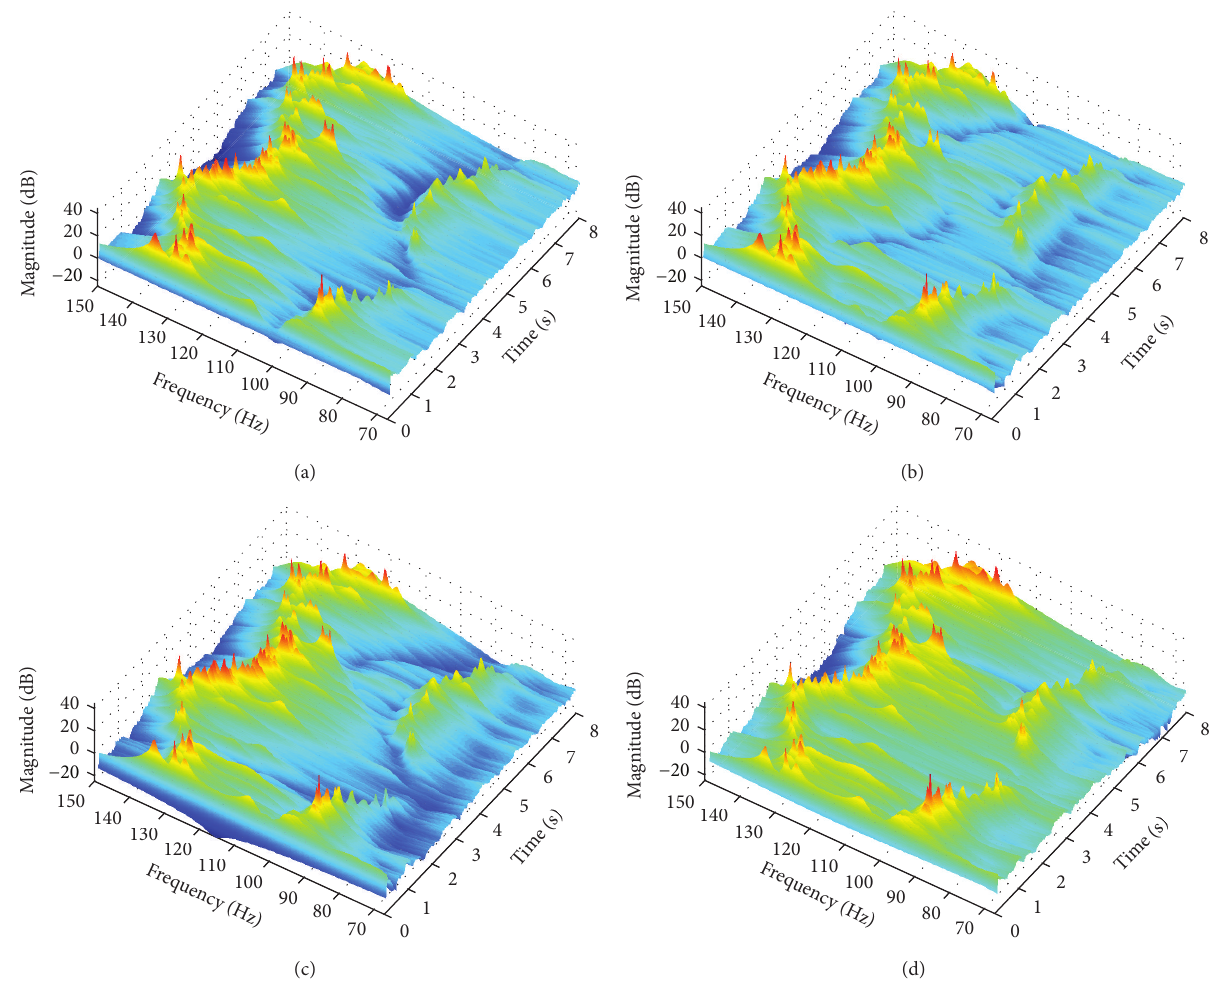
Figure 7: Cross power spectra for Outputs 1, 4, 7, and 11 referred to Output 7.